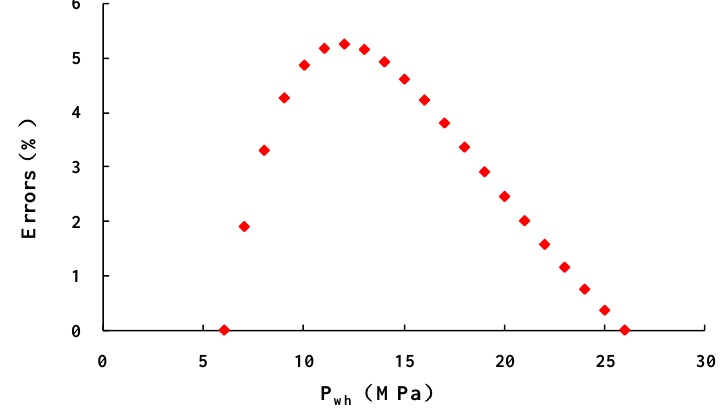
Figure 3—Errors of the Calculating Method.